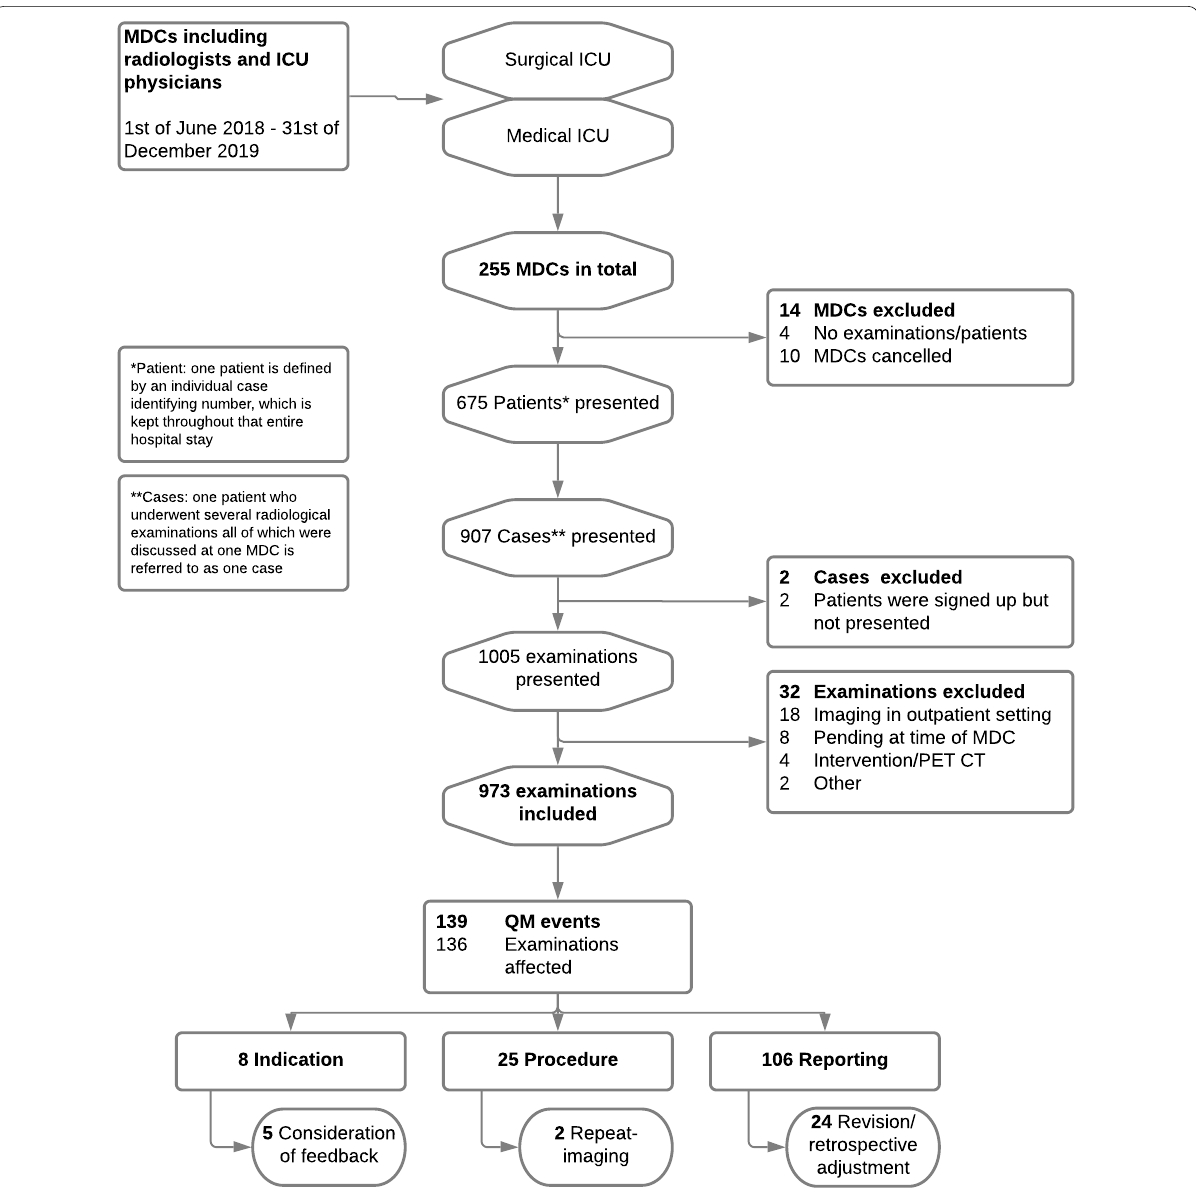
Fig. 1 Patient flow chart. Multidisciplinary conferences (MDC) for a medical and for a surgical intensive care unit (ICU) were introduced at this university hospital in 2018. The MDCs take place twice a week separately for the medical and surgical ICU. Radiologists present recent imaging studies which are then re-interpreted and discussed a second time with the treating ICU physicians. Bilateral feedback is provided and the occurrence of QM events is documented. Standardised protocols of all scheduled MDCs were collected over a 19-month period and analysed with regard to different QM categories and QM consequences. For some days, no MDCs were scheduled due to public holidays ( n reasons ( n =